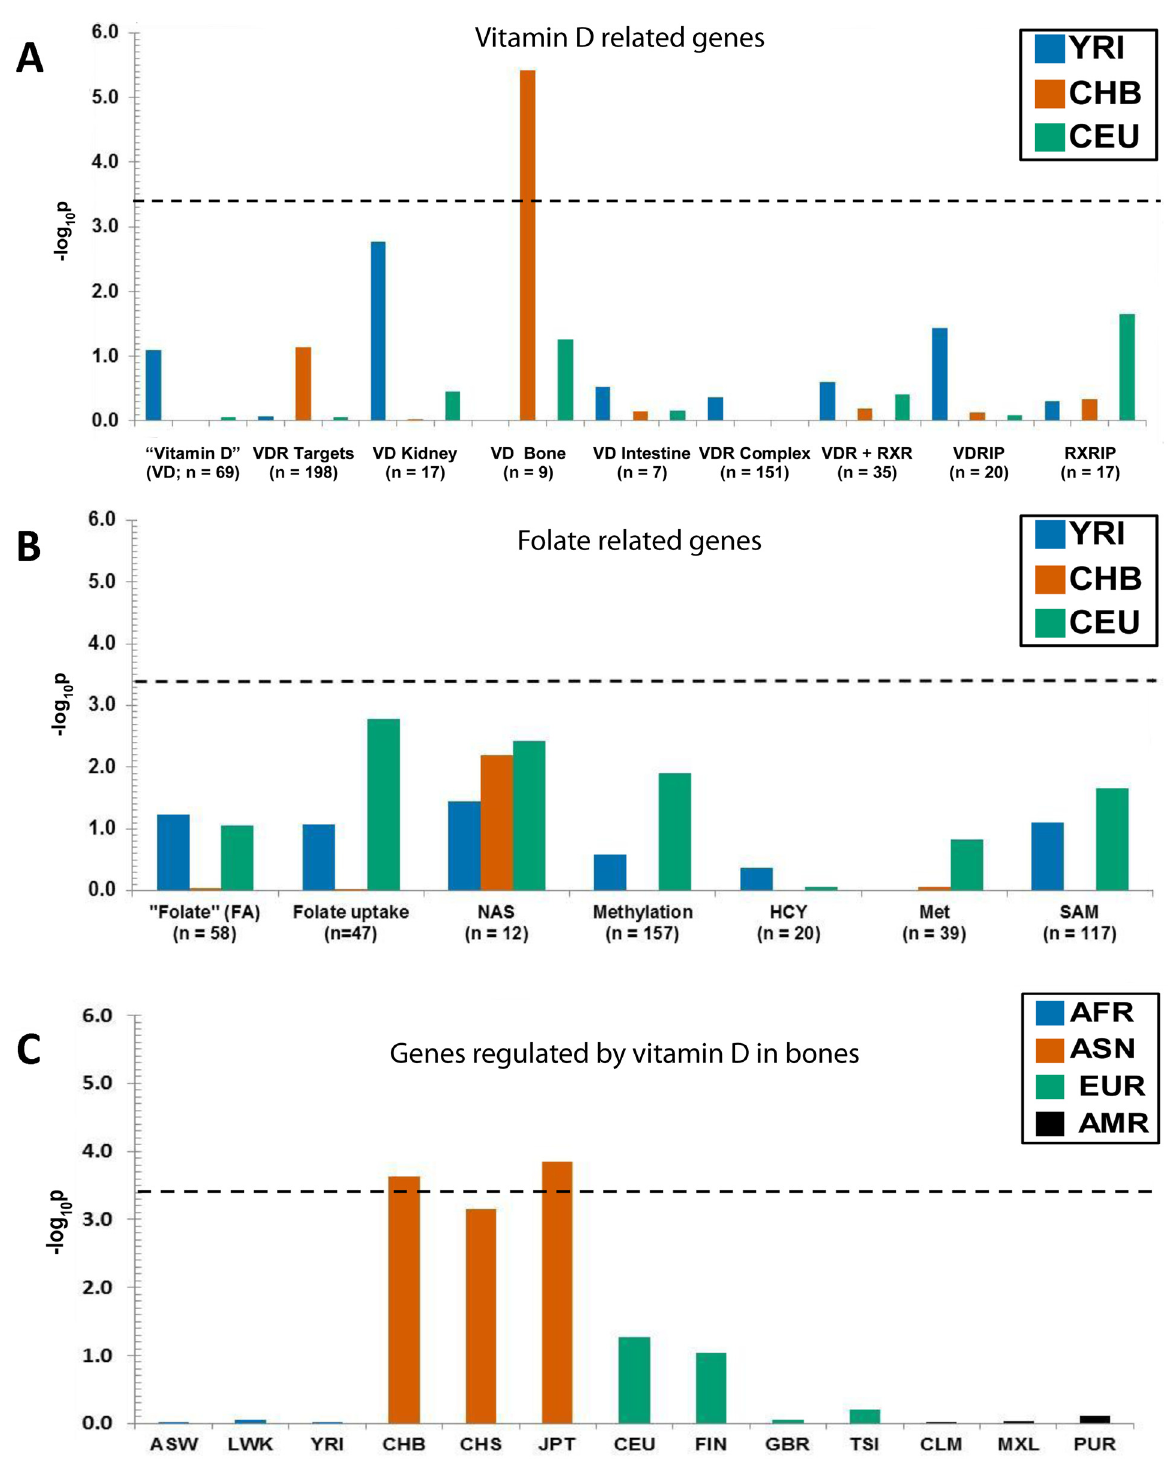
Fig 2. Positive selection in East Asians for genes regulated by vitamin D in bone. The y axis shows the − log 10 of the combined p-value summarized from individual frequency-spectrum-based analysis on sets of Vitamin D (A) and Folate (B) related genes in three continental populations. The dashed horizontal line depicts the threshold of the − log 10 p-value for multiple comparisons after applying the Bonferroni correction (13 populations x 9 gene sets). (C). Positive selection in East Asians for genes regulated by vitamin D in bone. African (AFR) populations included ASW (African Ancestry in Southwest